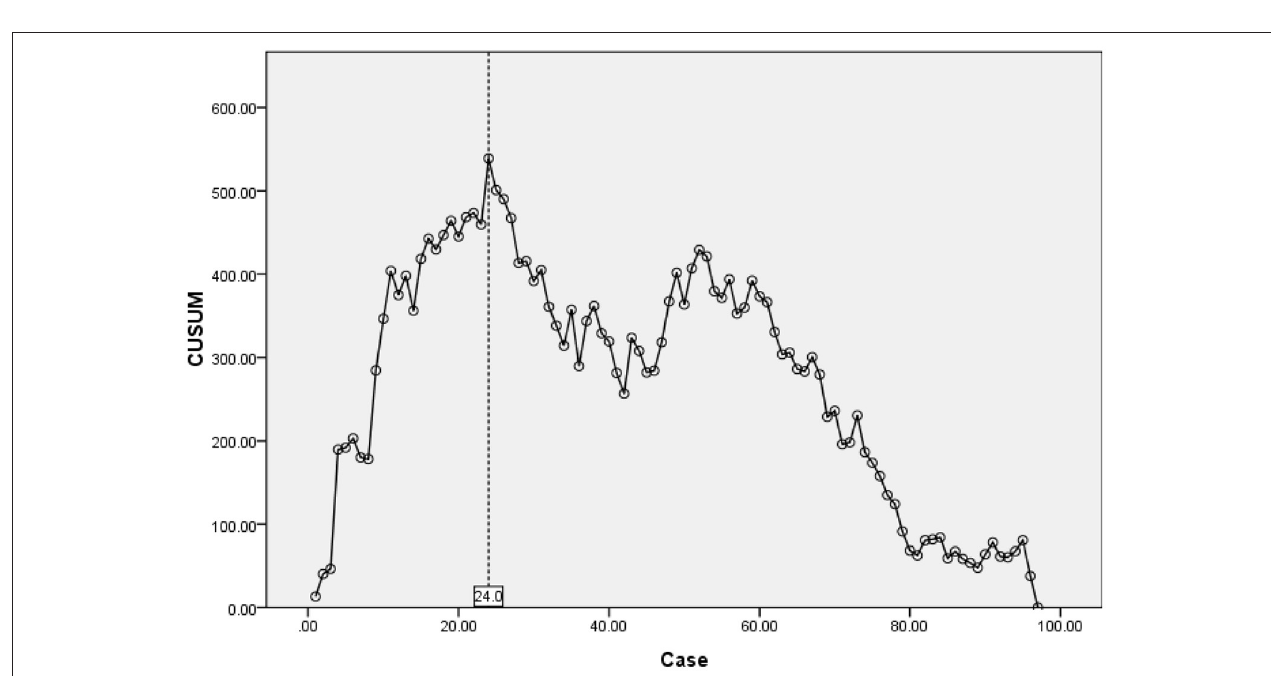
FIGURE 3 | CUSUM for learning curve reached the maximum in no. 24 case, revealed competency after 24 cases.